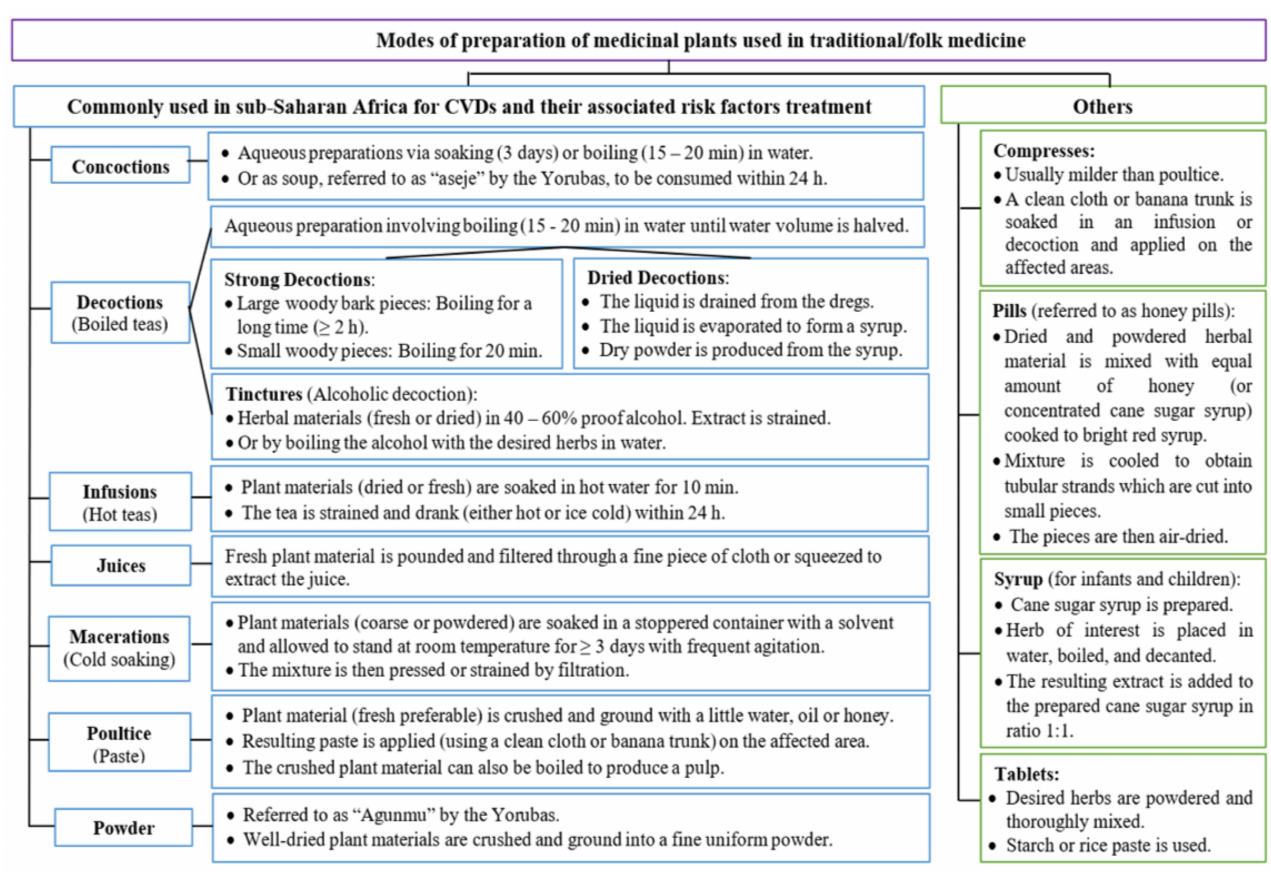
Figure 5. Connection between the different modes of preparing medicinal plants used for the treatment of cardiovascular diseases in sub-Saharan Africa. Adapted from: Nafiu et al. [28] and Azwanida